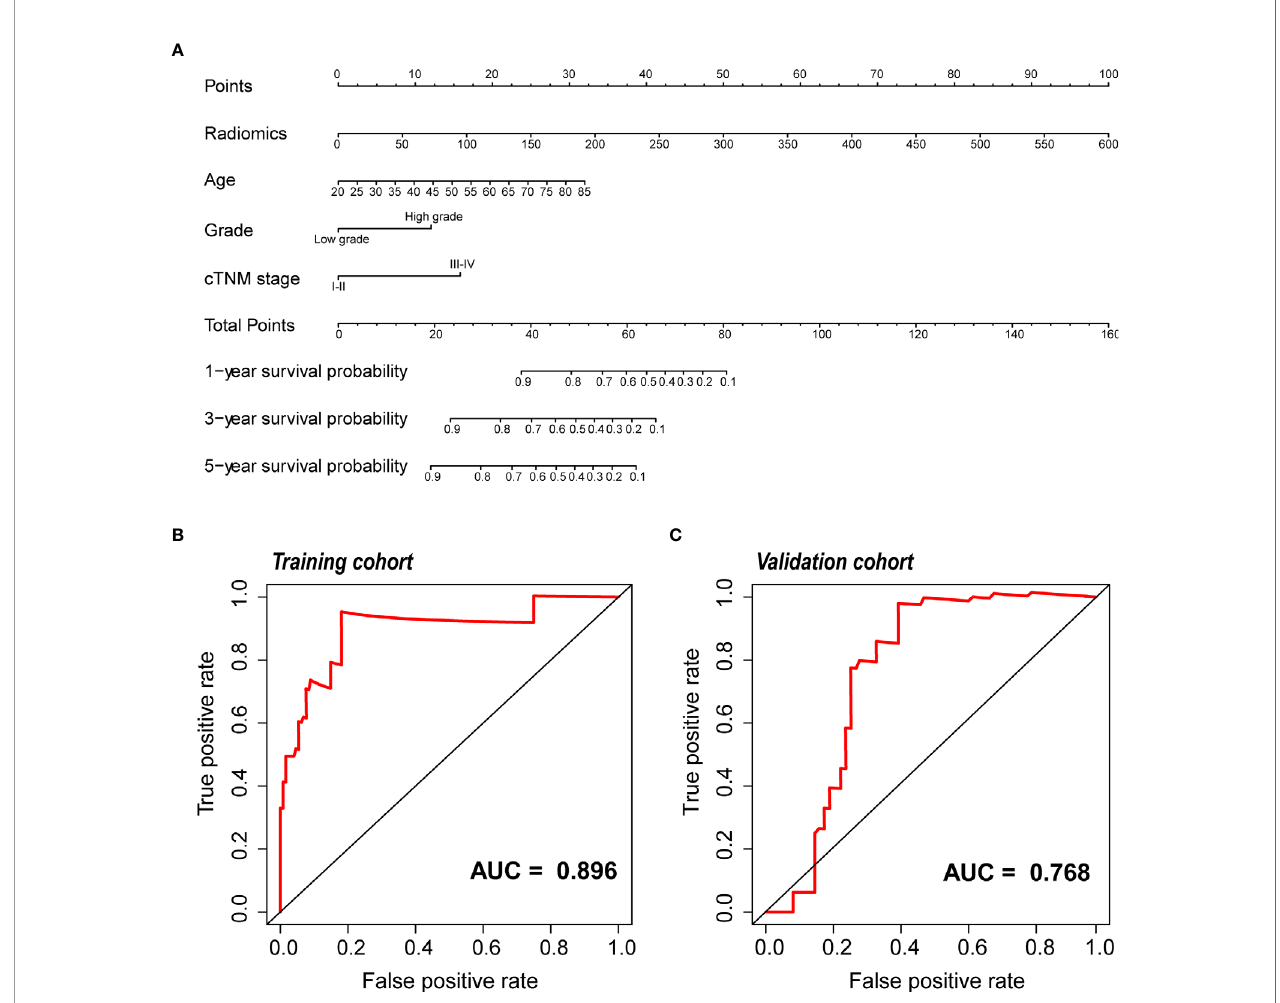
FIGURE 6 | Development and validation of the nomogram. (A) The nomogram for predicting 1, 3, and 5 years PFI of KIRC patients. An example of how to use the nomogram was presented below: a patient that has a radiomic score of 150 and is 60 years old; the pathological grade is high and the cTNM stage is IV. According to the point scale on the nomogram, the points for the four indicators are 25, 10, 12.5 and 0, then the points of these four factors are added up to a total score of 47.5. The next step is to fi nd 47.5 points on the total points scale below, and draw a line perpendicular to the following three axes. Then the probability of one-year PFI of this patient is between 0.8 and 0.9, which is about 0.82, indicating that the probability of one-year PFI of this patient is 82%, and the remaining probability values can be obtained in the same way. (B, C) ROC curve of the nomogram for predicting PFI in the training and the validation cohorts. PFI, progression-free interval; KIRC, Kidney Renal Clear Cell Carcinoma; ROC, relative operating characteristic curve